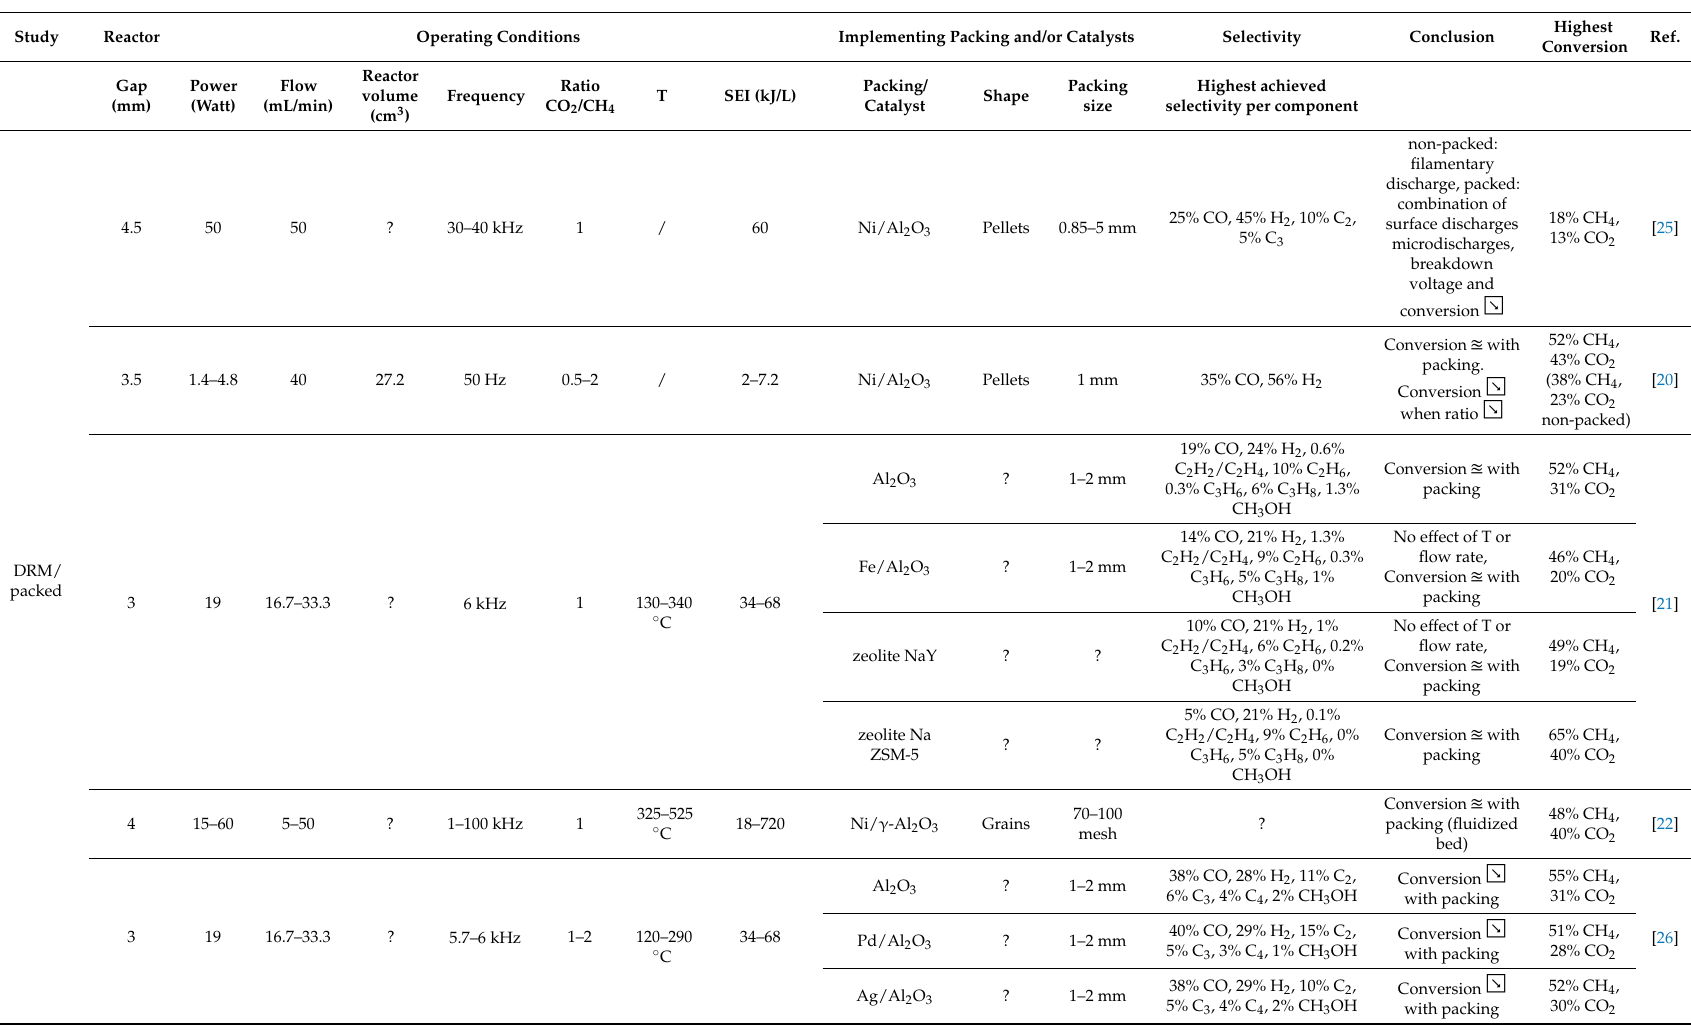
Table 1. Summary of a selection of literature for CO 2 splitting in a non-packed and a packed DBD reactor.